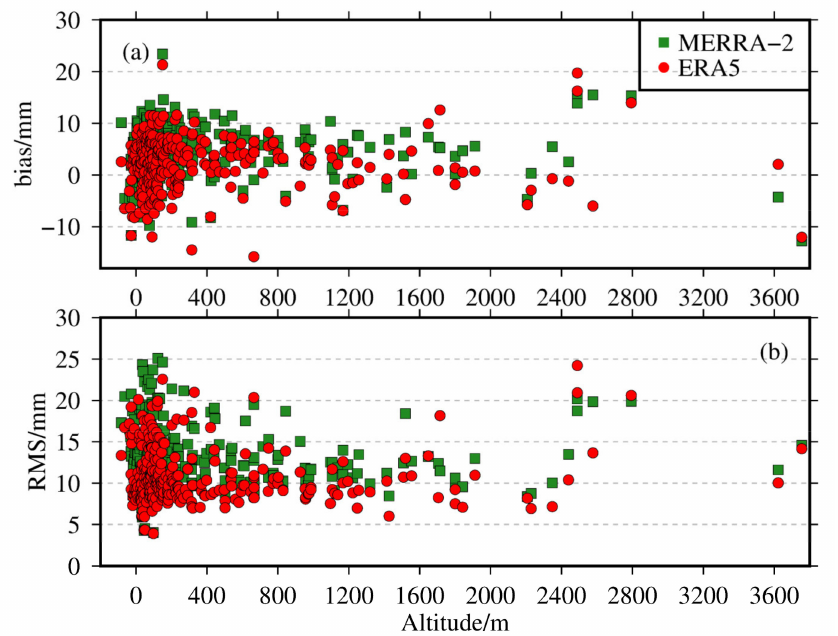
Figure 8. Variations in altitude of the annual average ( a ) bias and ( b ) RMS of ERA5 and MERRA-2 pressure-level ZTD with respect to GNSS ZTD over the globe from 2016 to 2017.